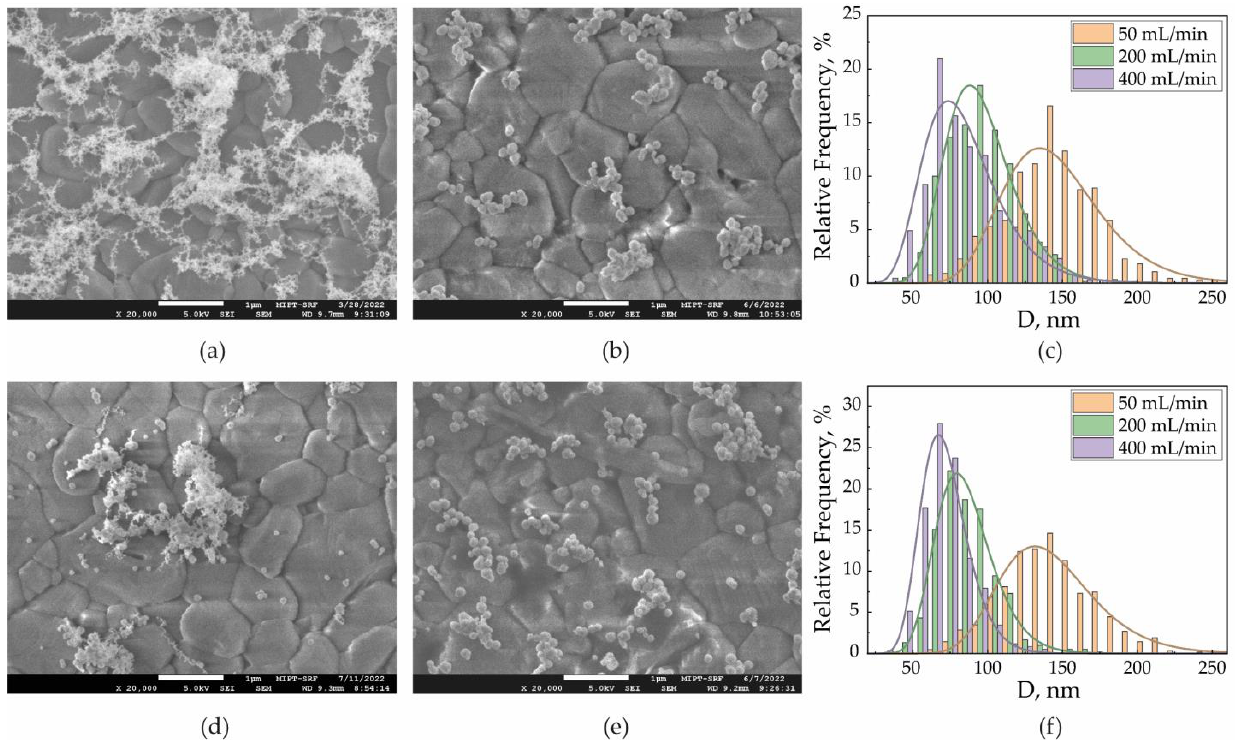
Figure 3. SEM images of SERS arrays fabricated with the aerosol flow of 50 mL/min from ( a ) primary agglomerates, ( b ) thermally modified NPs, and ( d ) laser-modified NPs with 4 mJ/cm 2 and ( e ) 12 mJ/cm 2 energy density. Size distributions for ( c ) thermally modified NPs and ( f ) laser-modified NPs with 12 mJ/cm 2 energy density.